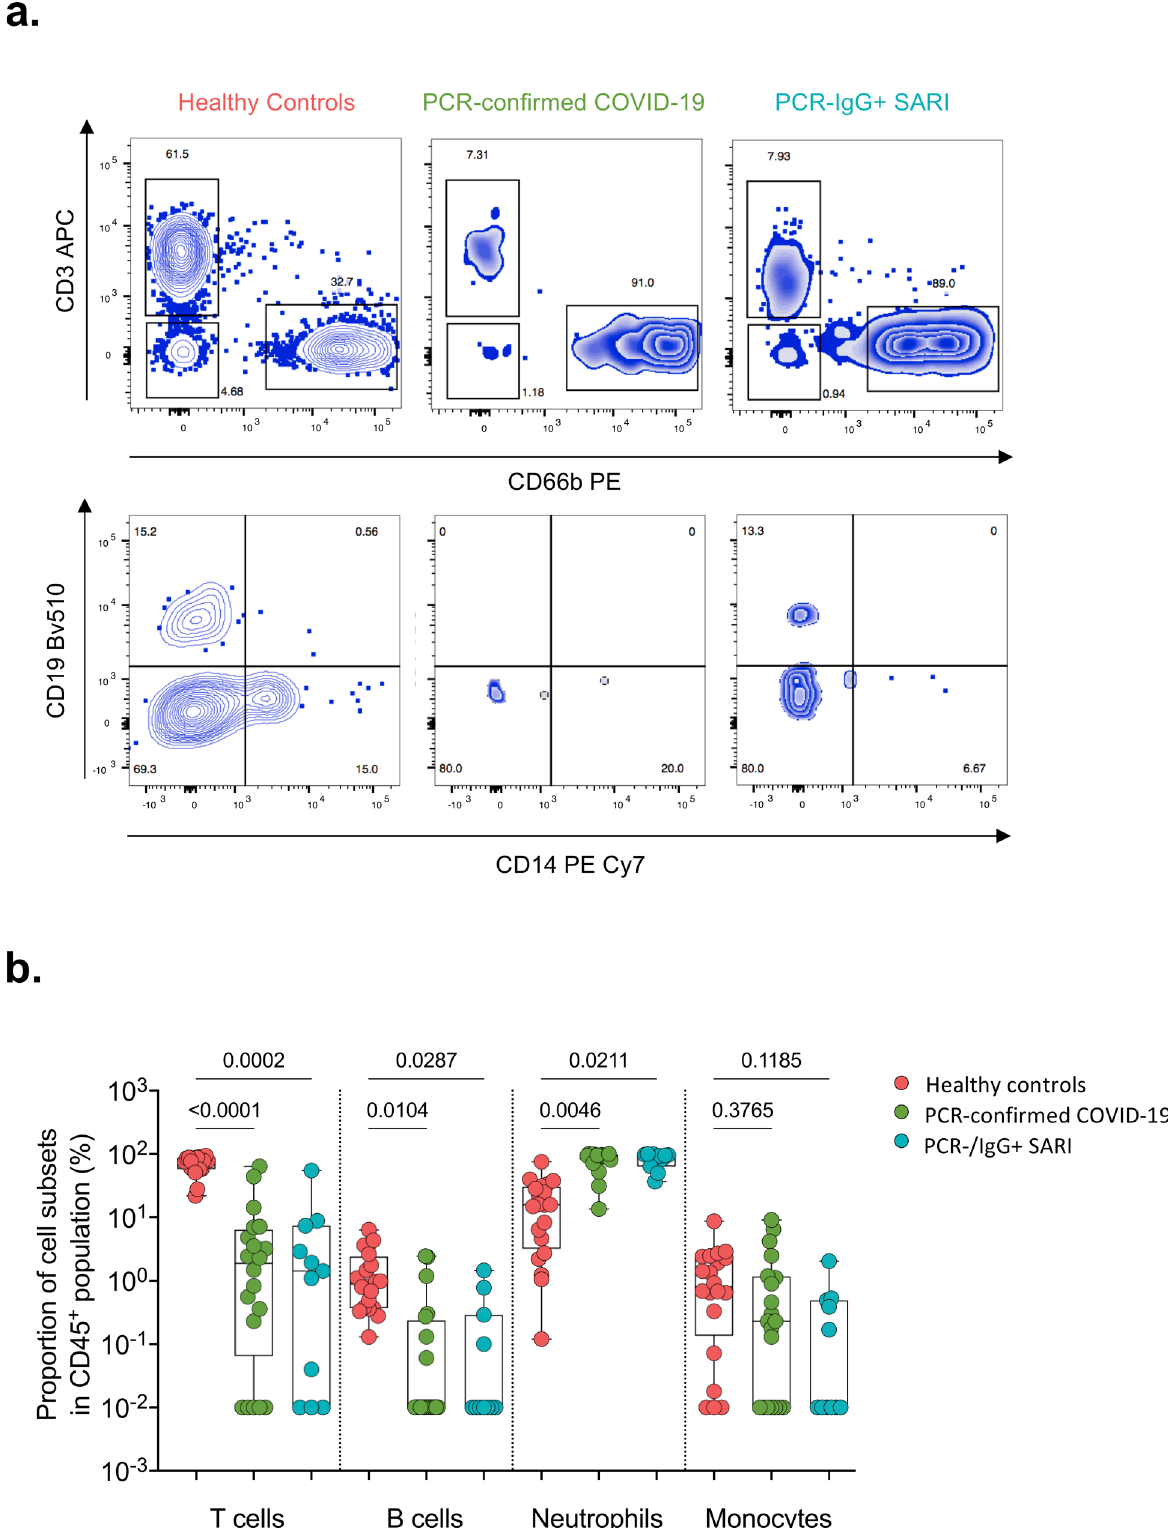
Fig. 4 Nasal cell composition in healthy controls, con fi rmed and suspected COVID-19 patients. a Representative fl ow cytometry plots for cellular composition in the nasal mucosa of healthy controls, PCR-con fi rmed COVID-19 and PCR − /IgG + SARI patients. b Proportions of T cells, B cells, neutrophils and monocytes in nasal mucosa of healthy controls and COVID-19 patients. For all boxplots, box boundaries correspond to 25th and 75th percentiles; whiskers extend to a maximum or minimum greatest value. Data were analysed using Kruskal – Wallis test, two-sided (healthy controls, n = 20; PCR- con fi rmed COVID-19, n = 20; PCR − /IgG + SARI, n = 11). SARS-CoV-2 severe acute respiratory syndrome coronavirus 2, COVID-19 coronavirus disease of 2019, PCR polymerase chain reaction, IgG immunoglobulin G, SARI severe acute respiratory infection. Source data are provided as a Source Data fi